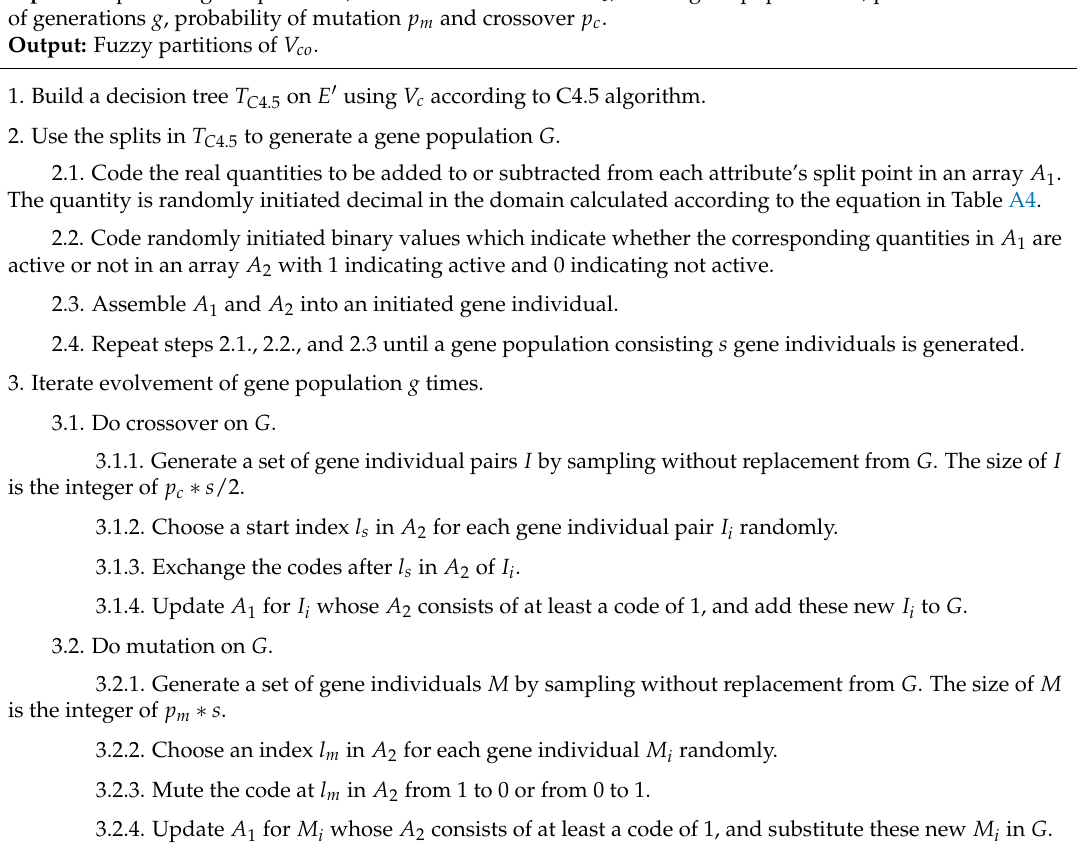
Table A3. Steps for doing fuzzy partitioning of continuous